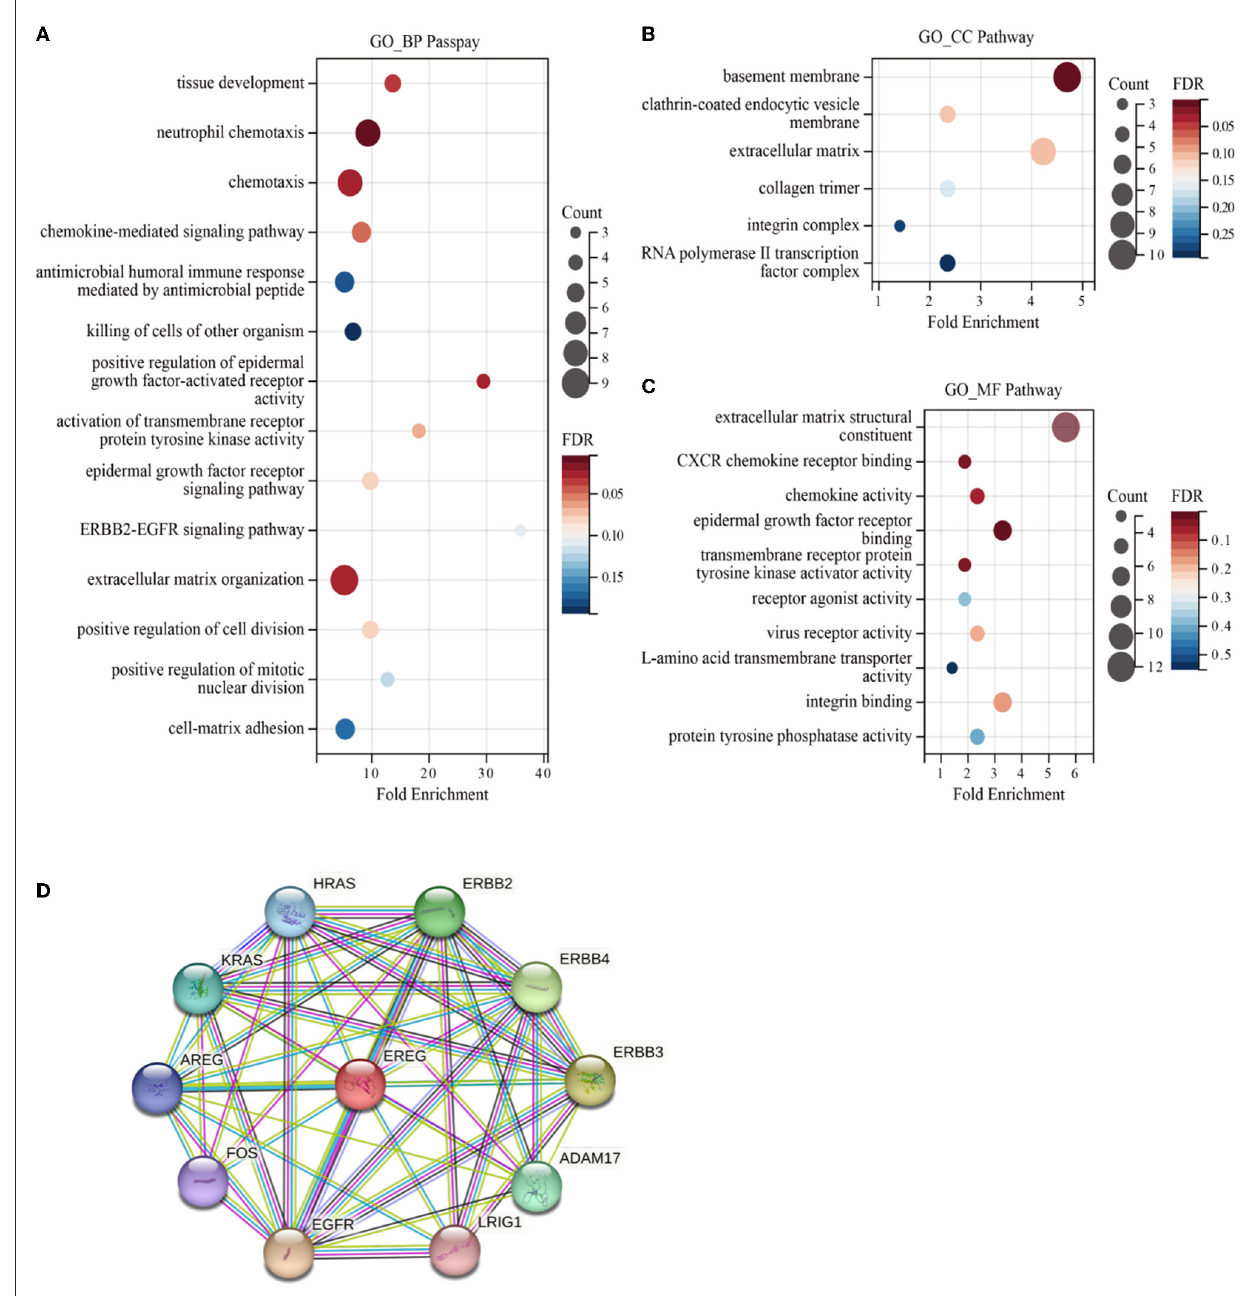
FIGURE4 GO enrichment of EREG-correlated genes and protein interaction analysis of EREG. The bubble diagrams show the GO_BP (biological process) (A) , GO_CC (cellular component) (B) , and GO_MF (molecular function) pathway terms (C) of the genes correlated with EREG in the TCGA CESC dataset, respectively. The size of the bubble represents the number of associated genes included in the term. The shade of the color represents the FDR (false discovery rates). (D) Protein interaction network sketch map in STRING [STRING: functional protein association networks (string-db.org)]. The center of the map was EREG, and the periphery sphere represents the proteins predicted to interact with